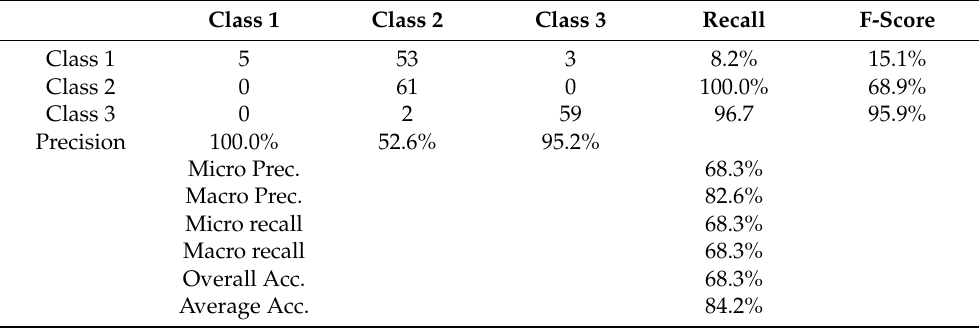
Table 7. Confusion matrix assessing CNN trained with “with shadows” images, tested with “no or fewer shadows”.